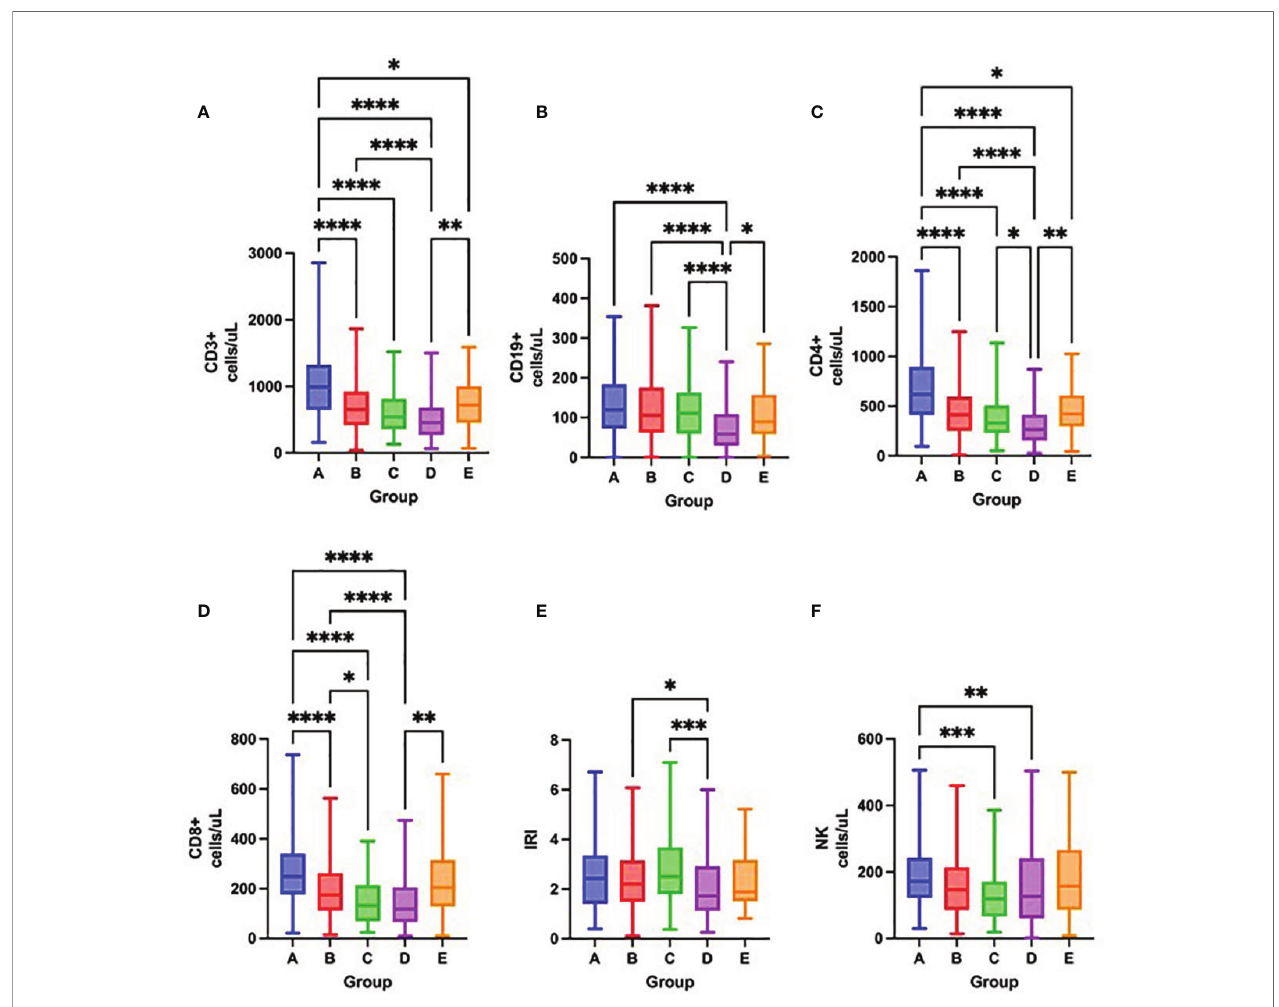
FIGURE 5 | Differences in the total number of lymphocyte subpopulations measured by fl ow cytometry – CD3 + cells (A) , CD19 + cells (B) , CD4 + cells (C) , CD8 + cells (D) , IRI (immunoregulatory index CD4 + /CD8 + ) (E) , NK cells (F) among groups A – E on admission to the hospital, Kruskal-Wallis test. *p < 0.05; **p < 0.01; ***p < 0.001; ****p <